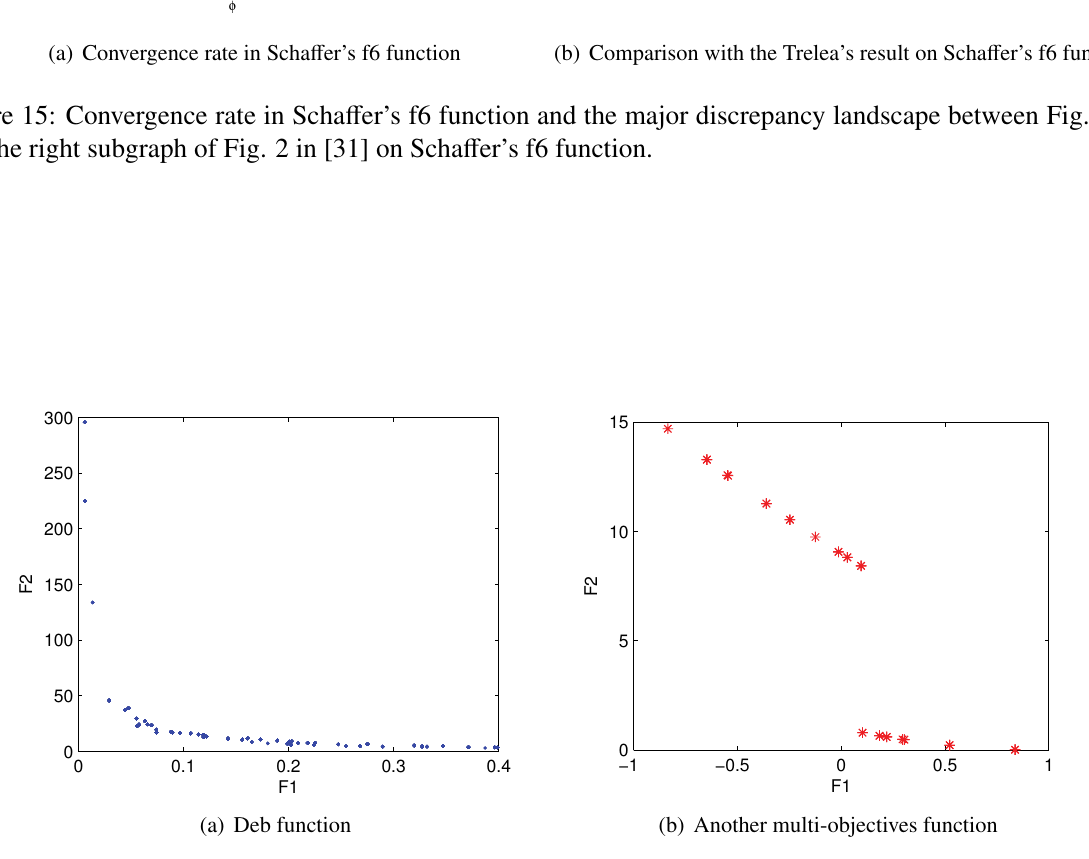
Figure 16: PSO algorithm with di ff erent topology handles with multi-objectives optimization